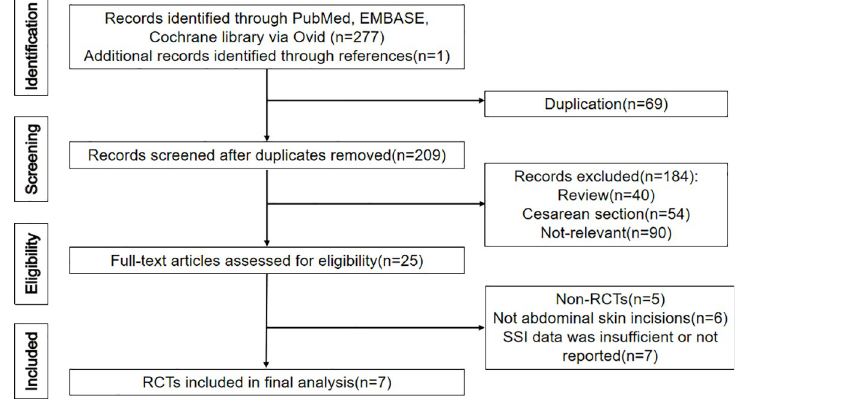
Fig 1. The PRISMA flow chart for the literature